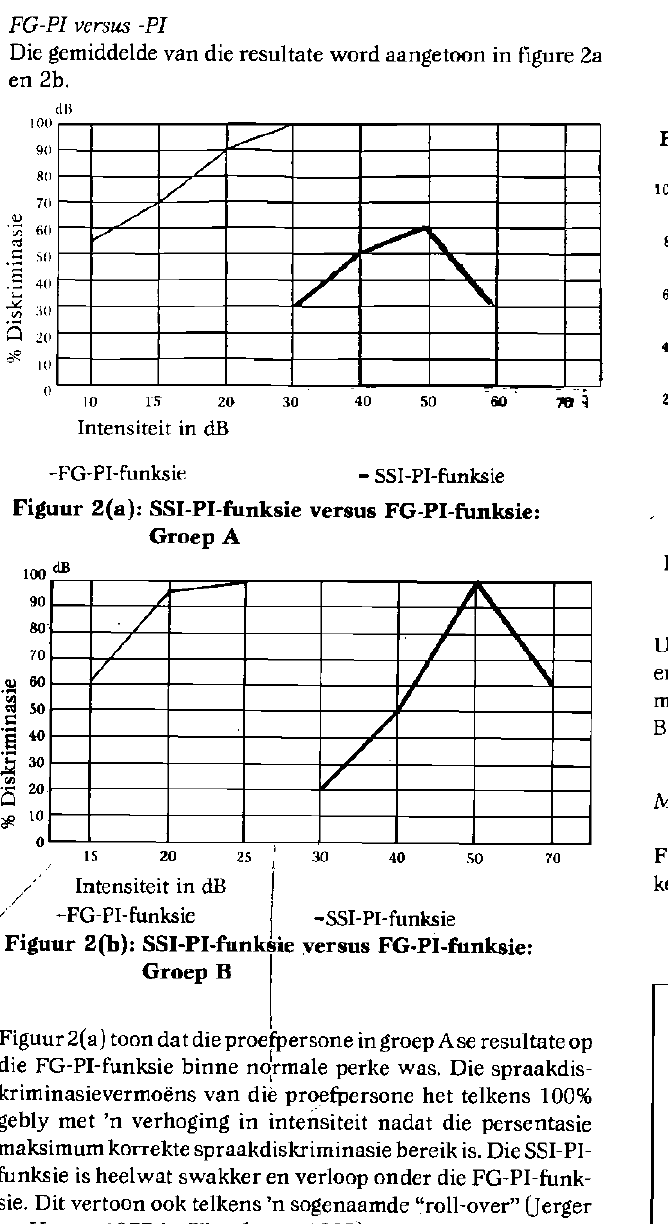
- Met o.m. Figuur 3(a): Resultate van SSI-IKB (links)